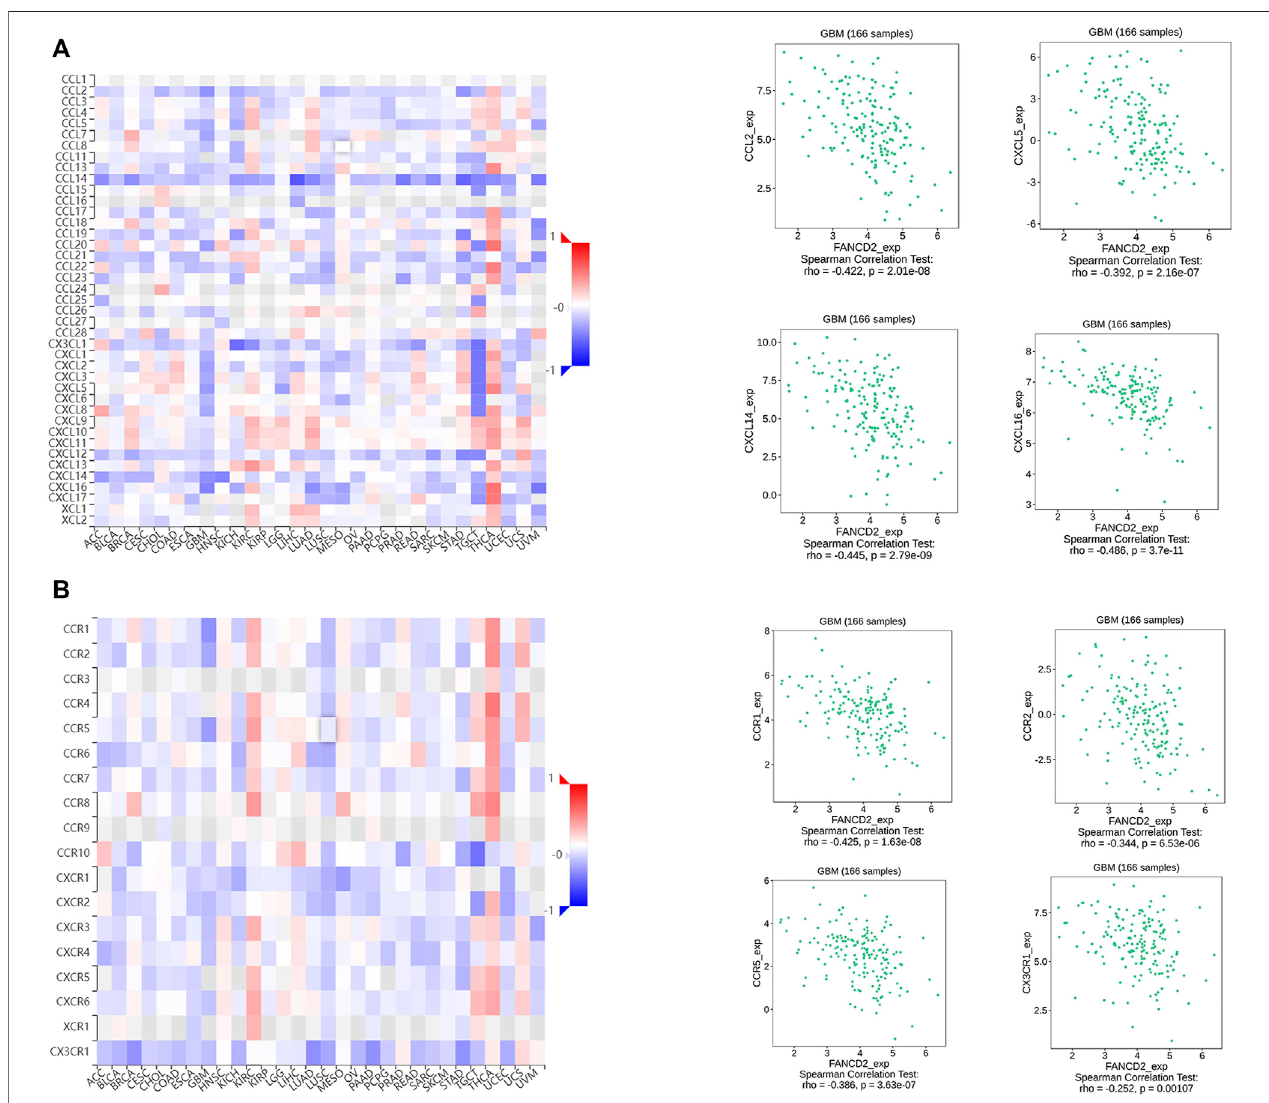
FIGURE 8 | Associations between FANCD2 expression and chemokines-chemokines receptors from the TISIDB database (A) The top four chemokines (CCL2, CXCL5, CXCL14, and CXCL16) negatively correlatedwithFANCD2 (B) Thetopfourreceptors (CCR1,CCR2,CCR5,and CX3CR1) negatively correlatedwithFANCD2.